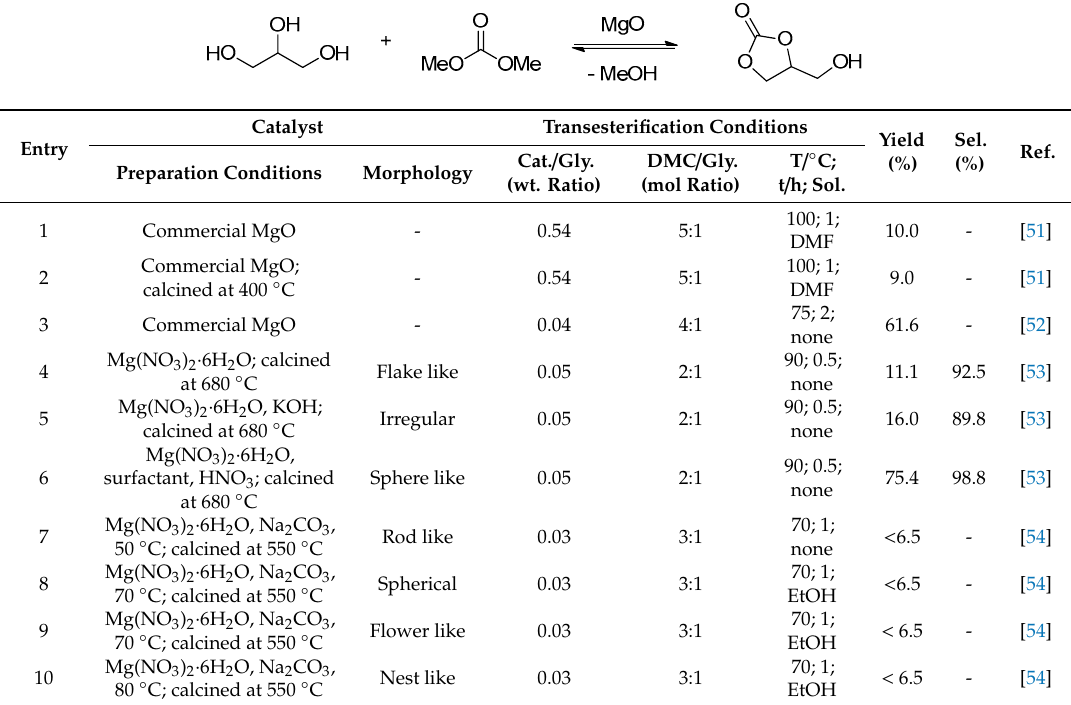
Table 1. MgO catalyzed transesterification of glycerol 1 .